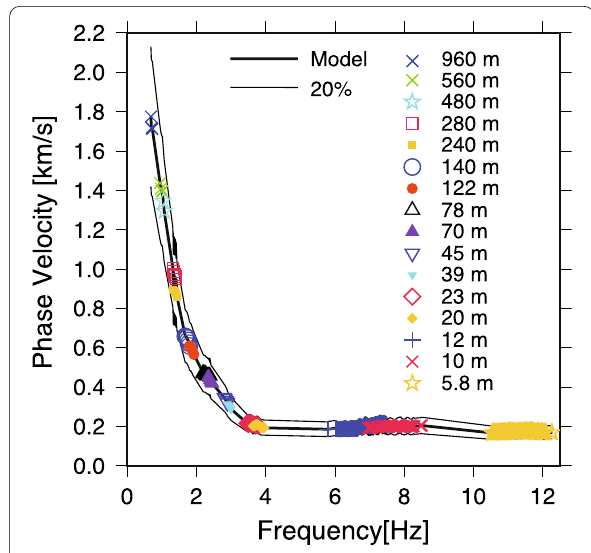
Fig. 8 Comparison between the reference model (black lines) and the observed phase velocities of each array (colored marks). The thin curves along with the model curve represent the discrepancies from the model. Observed dispersion curves are plotted only partially in a wavelength range from 2.4 r to 2.8 r . The figures in the legend indicate the array radii